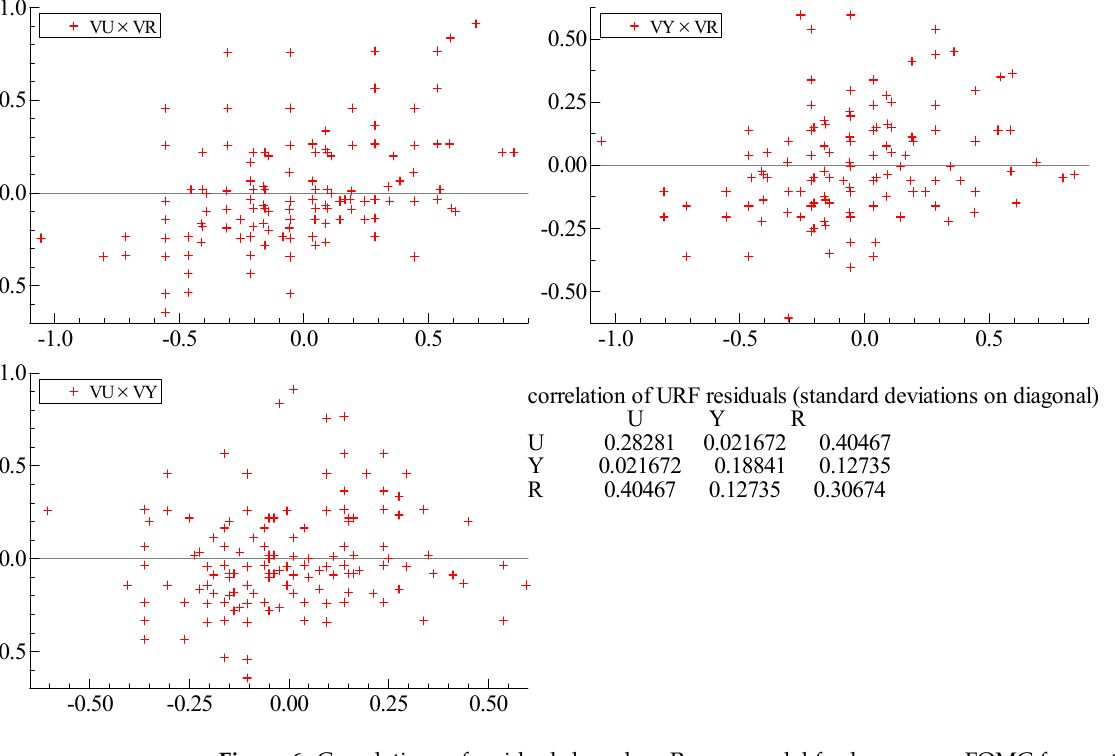
Figure 6. Correlations of residuals based on Romer model for longer-run FOMC forecasts for the Interest Rate (VR), Unemployment (VU), and GDP Growth (VY)—January 2012–December 2016.